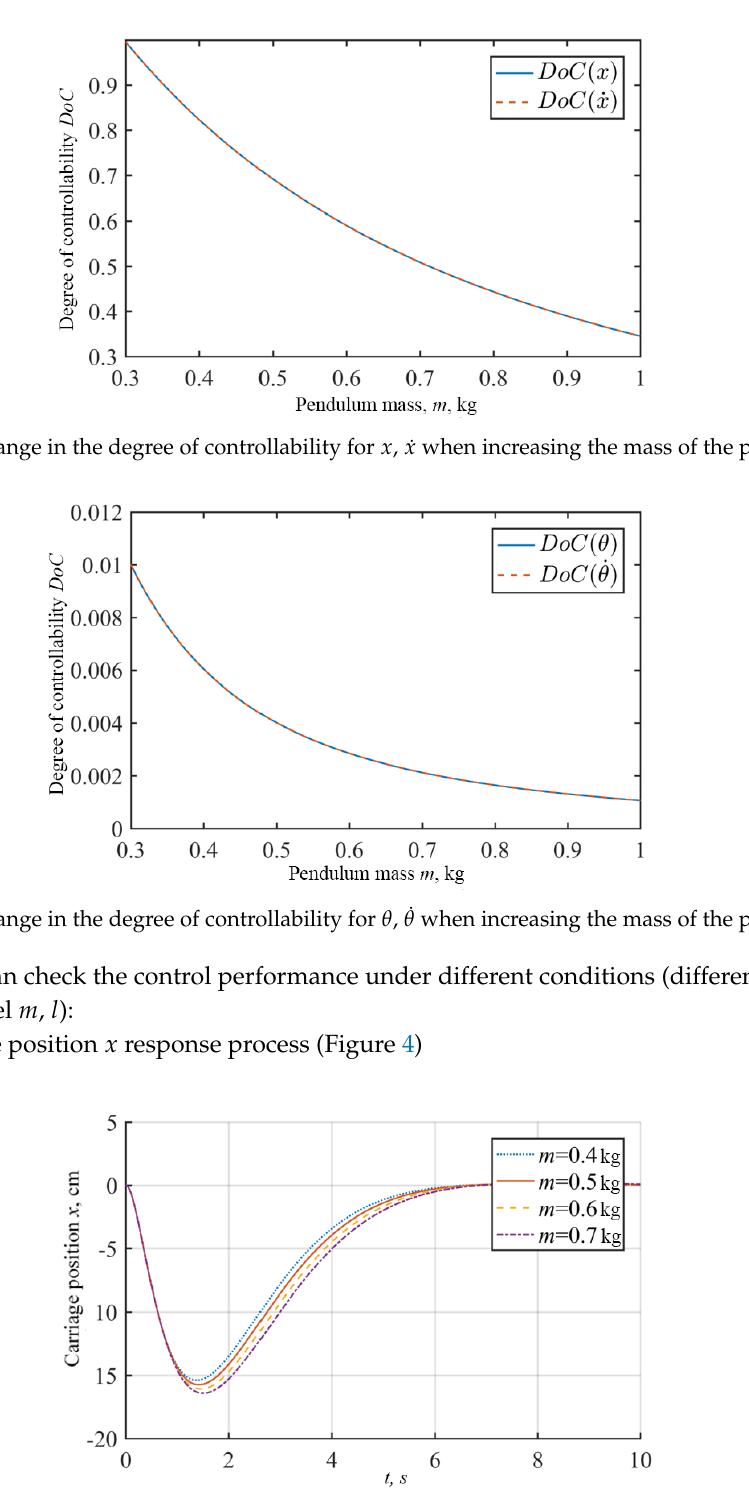
Figure 4. Carriage position x at different m